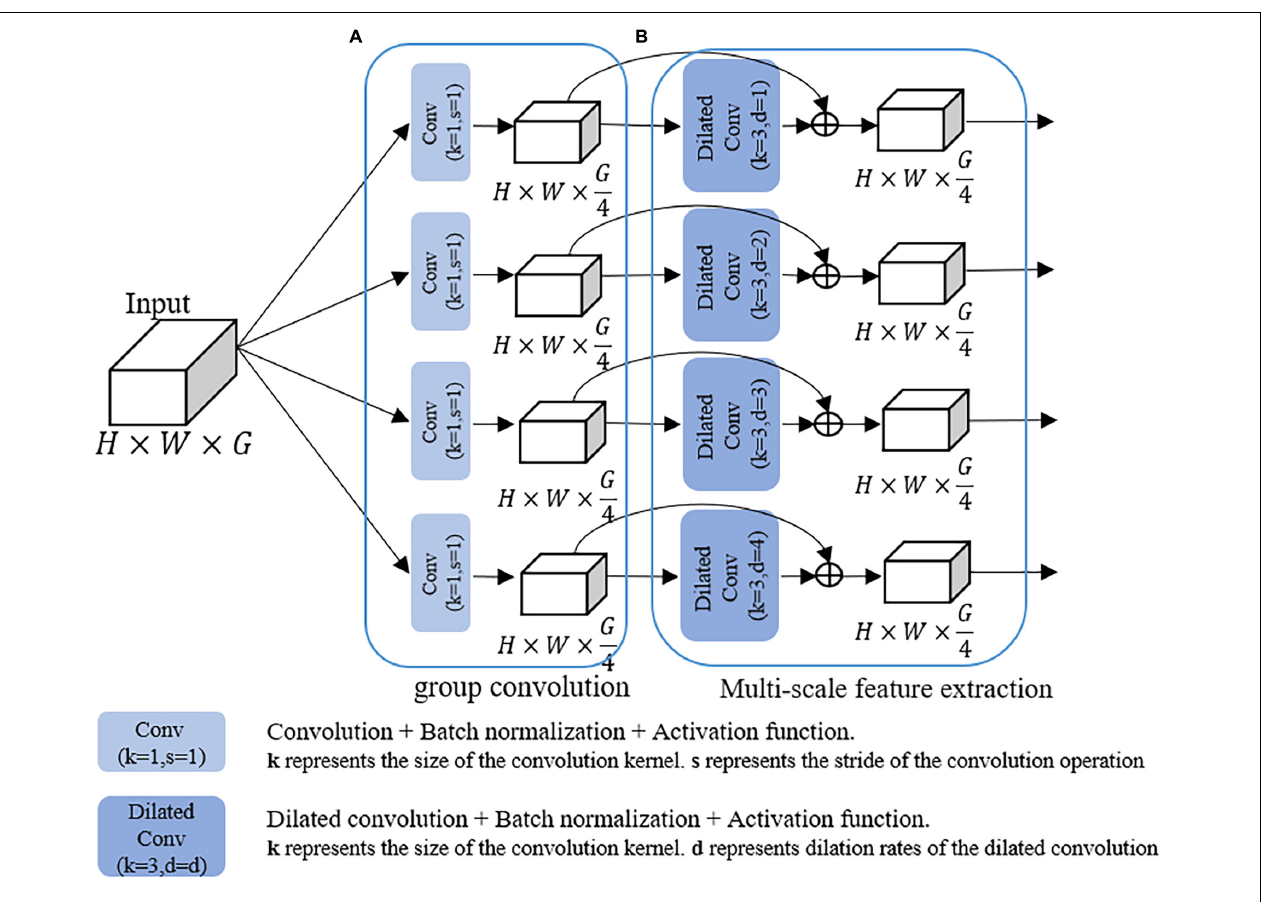
FIGURE 3 | The structure of the GMDC module. (A) Multi-branch group convolution. (B) Multi-branched dilated convolution with different dilation rates.